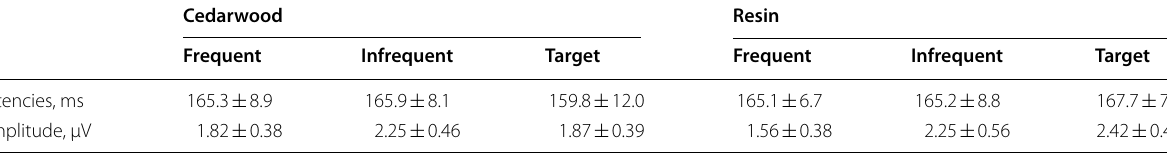
The data are mean